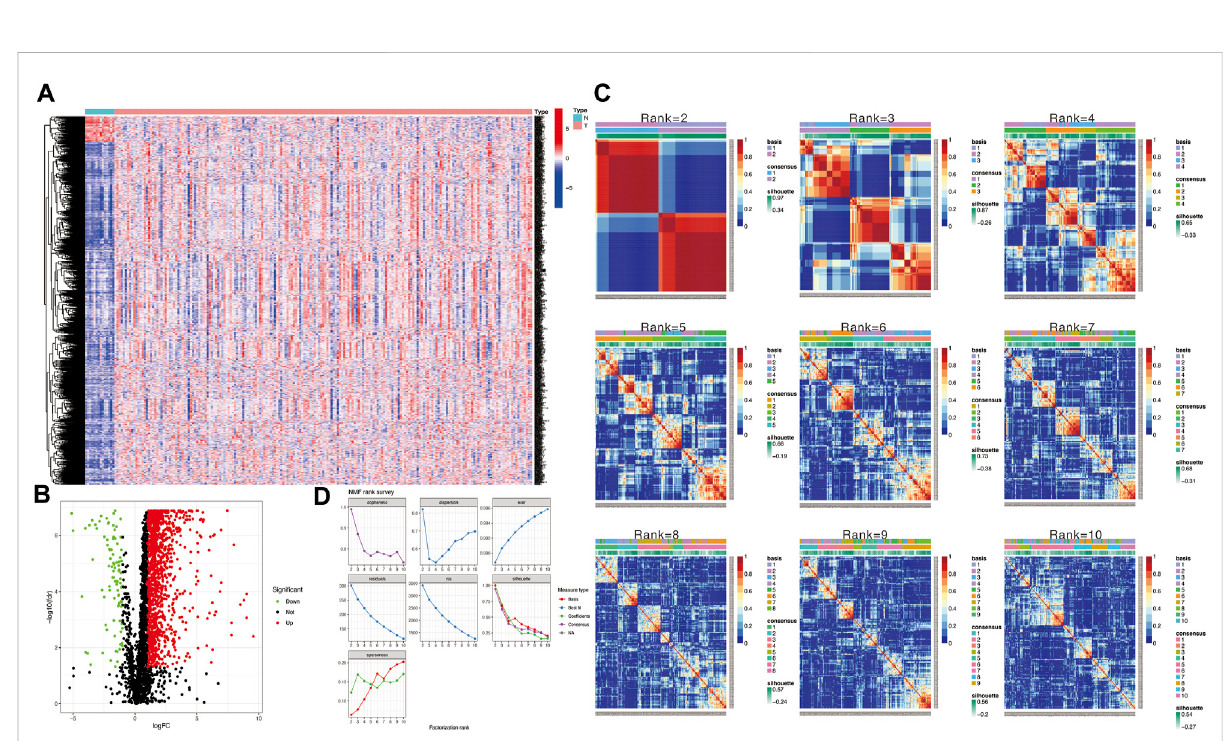
FIGURE 2 (A) Heatmap to show TME-related differentially expressed genes between HNSCC and normal tissue samples. (B) Volcano plot displays 1,335 TME-related differentially expressed genes in TCGA HNSCC cohort. (C) Non-negative matrix factorization (NMF) clustering was conducted to classify HNSCC patients into 2 to 10 different subtypes, and relevant heatmaps were generated. (D) NMF rank survey with multiple parameters (including dispersion, cophenetic, residuals, evar, rss, and silhouette coef fi cients) to determine the optimal value for consensus